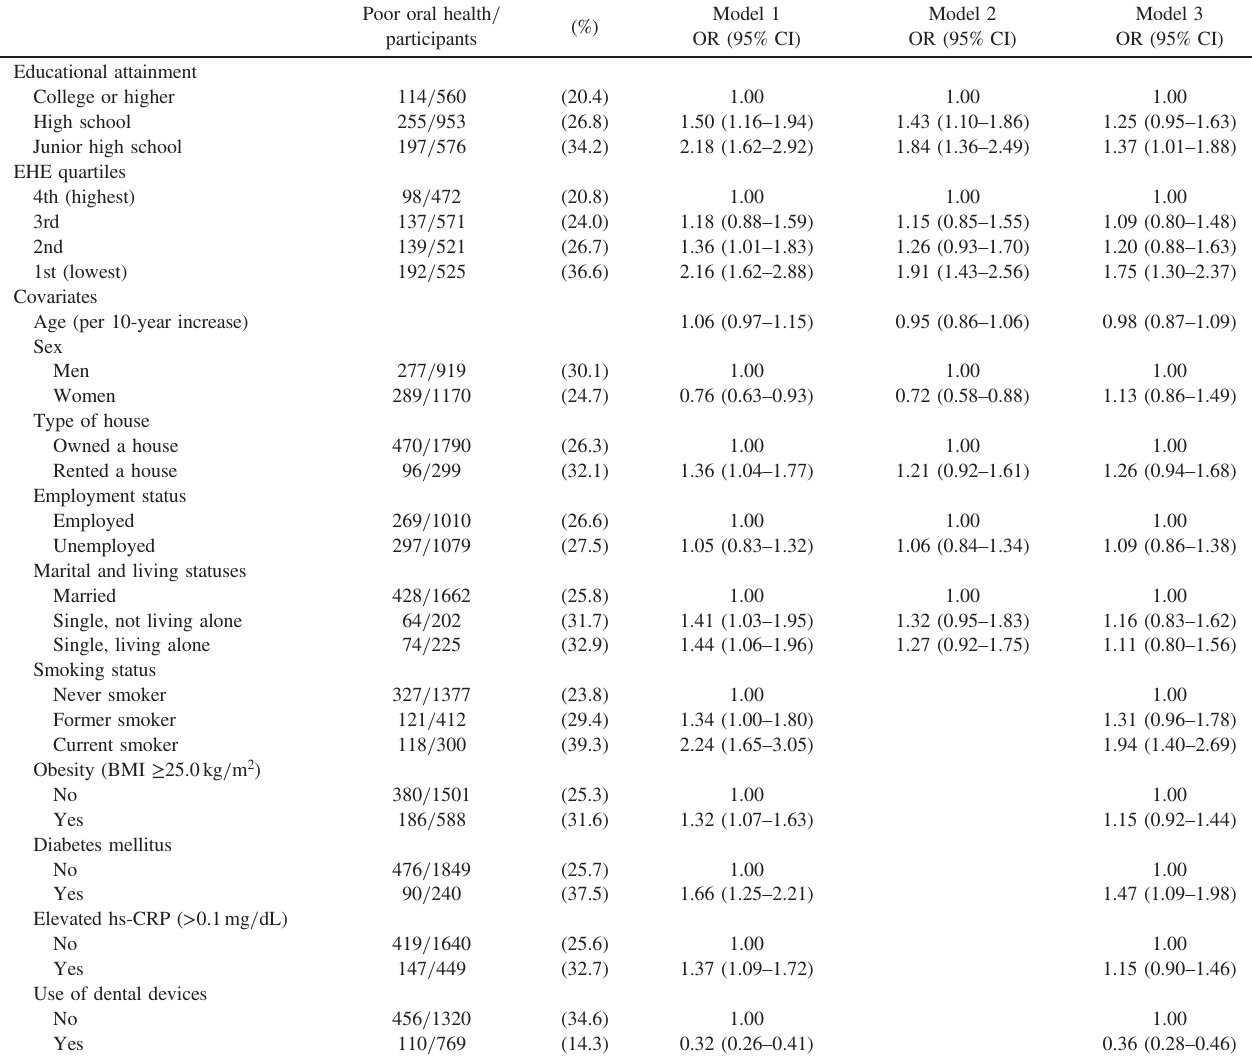
Table 2. Associations of educational attainment and EHE with poor oral health: NIPPON